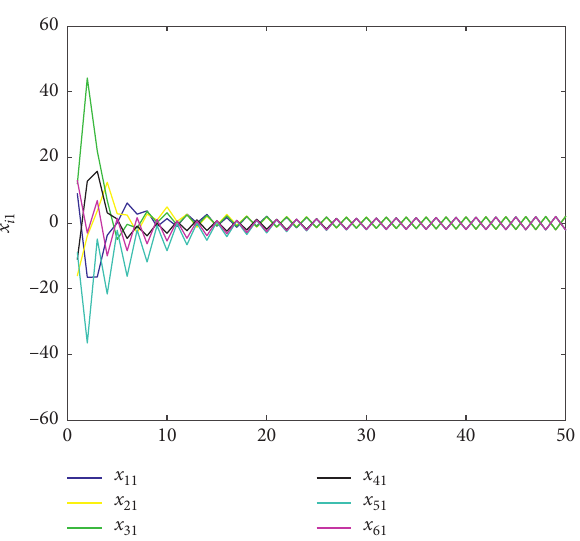
Figure 2: The trajectories of x